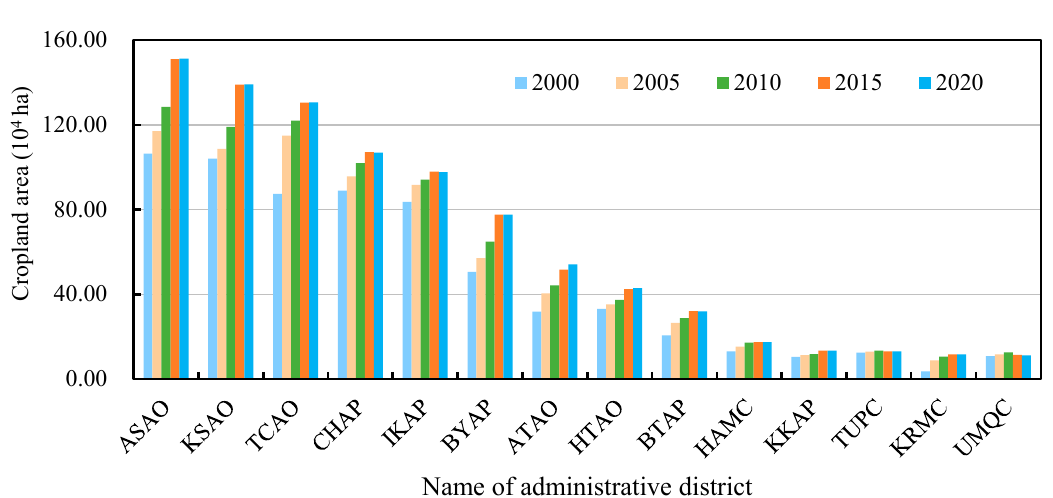
Figure 3. Changes in cropland area in different prefectures of Xinjiang during 2000–2020. In terms of the different study periods, stage differences were also found in the changes Table 5. Differences in the NCAC and ACRC in different prefectures of Xinjiang during 2000–2020. in the cropland scale of various prefectures in Xinjiang (Table 5). From 2000 to 2005, the newly added cropland in Xinjiang was mainly distributed in TCAO, ASAO, ATAO and IKAP, accounting for 60.59% of the total newly added cropland in Xinjiang. From 2005 to 2010, the newly added cropland in Xinjiang was mainly distributed in ASAO, KSAO, BYAP, TCAO and CHAP, accounting for 72.82% of the total newly added cropland in Xinjiang. From 2010 to 2015, the cropland scale of UMQC (the ACRC was − 1.94%/yr) and TUPC